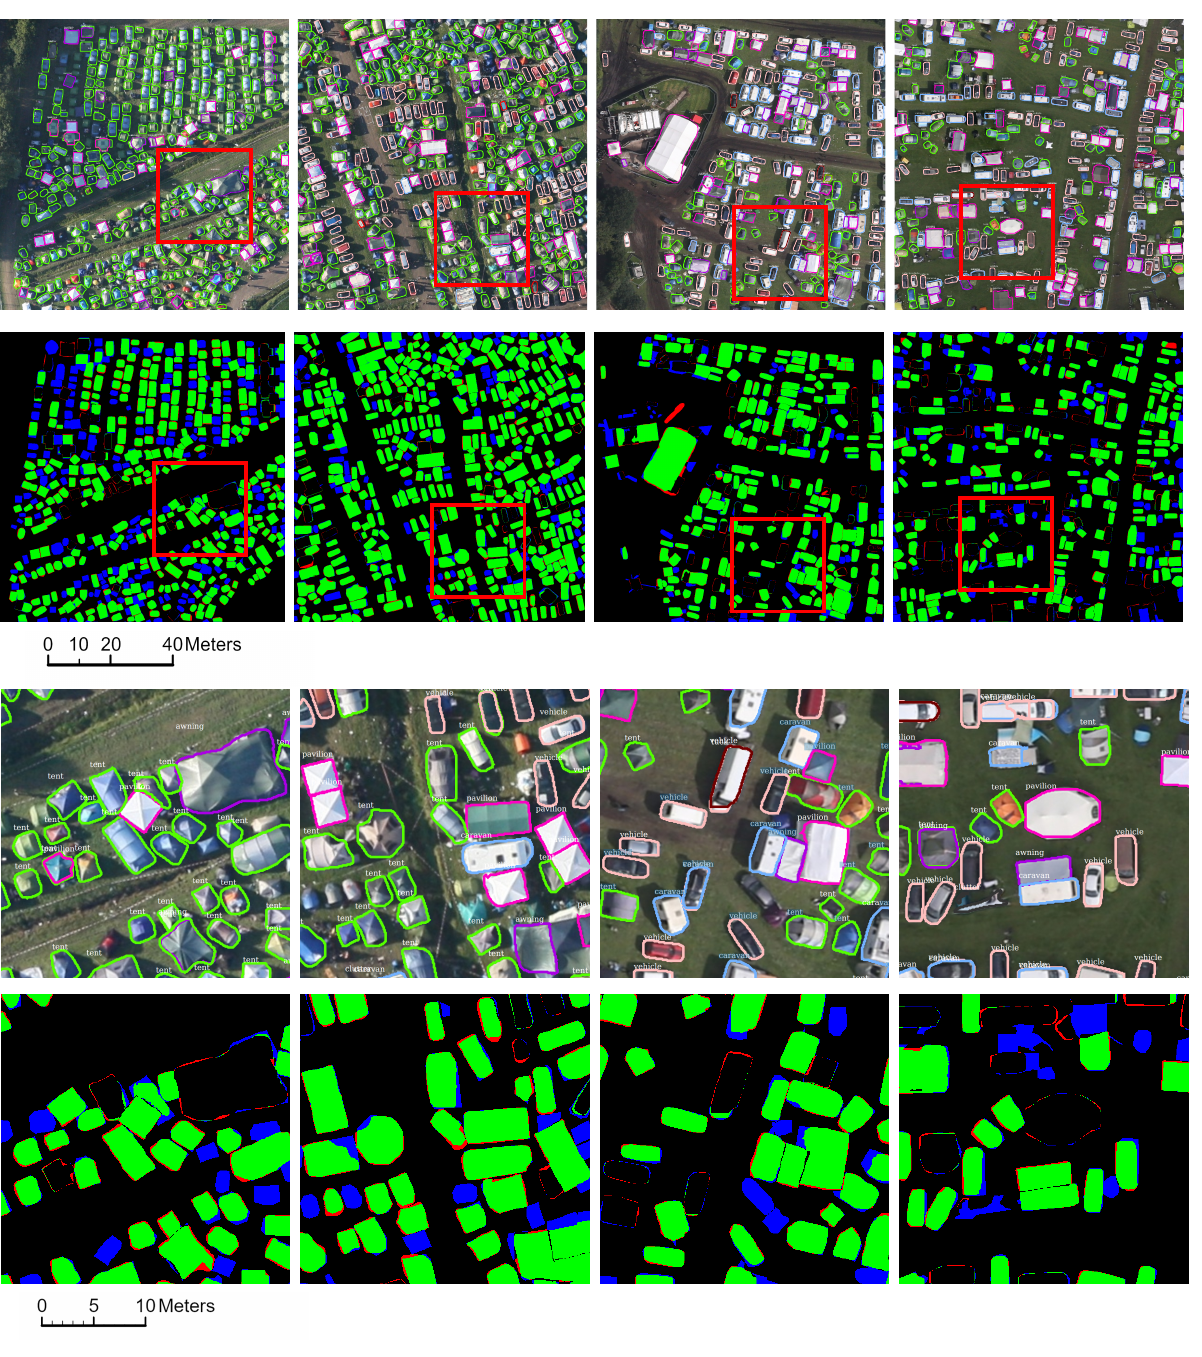
Figure 5. Samples of visual outputs for mask segmentation and confusion in the DLR-AerialTent test set. Color codes for the first and third row: (cid:4)(cid:4)(cid:4)(cid:4)(cid:4)(cid:4)(cid:4)(cid:4)(cid:4)(cid:4)(cid:4)(cid:4)(cid:4)(cid:4)(cid:4)(cid:4)(cid:4) tent: sleep function, (cid:4)(cid:4)(cid:4)(cid:4)(cid:4)(cid:4)(cid:4)(cid:4)(cid:4)(cid:4)(cid:4)(cid:4)(cid:4)(cid:4)(cid:4)(cid:4)(cid:4) small vehicle/transporter, (cid:4)(cid:4)(cid:4)(cid:4)(cid:4)(cid:4)(cid:4)(cid:4)(cid:4)(cid:4)(cid:4)(cid:4)(cid:4)(cid:4)(cid:4)(cid:4)(cid:4) trailer, (cid:4)(cid:4)(cid:4)(cid:4)(cid:4)(cid:4)(cid:4)(cid:4)(cid:4)(cid:4)(cid:4)(cid:4)(cid:4)(cid:4)(cid:4)(cid:4)(cid:4) truck/bus, (cid:4)(cid:4)(cid:4)(cid:4)(cid:4)(cid:4)(cid:4)(cid:4)(cid:4)(cid:4)(cid:4)(cid:4)(cid:4)(cid:4)(cid:4)(cid:4)(cid:4) camper/caravan, (cid:4)(cid:4)(cid:4)(cid:4)(cid:4)(cid:4)(cid:4)(cid:4)(cid:4)(cid:4)(cid:4)(cid:4)(cid:4)(cid:4)(cid:4)(cid:4)(cid:4) pavilion/large tent: assembly and supply function, (cid:4)(cid:4)(cid:4)(cid:4)(cid:4)(cid:4)(cid:4)(cid:4)(cid:4)(cid:4)(cid:4)(cid:4)(cid:4)(cid:4)(cid:4)(cid:4)(cid:4) awning, tarpaulin, (cid:4)(cid:4)(cid:4)(cid:4)(cid:4)(cid:4)(cid:4)(cid:4)(cid:4)(cid:4)(cid:4)(cid:4)(cid:4)(cid:4)(cid:4)(cid:4)(cid:4) inflatable pool, (cid:4)(cid:4)(cid:4)(cid:4)(cid:4)(cid:4)(cid:4)(cid:4)(cid:4)(cid:4)(cid:4)(cid:4)(cid:4)(cid:4)(cid:4)(cid:4)(cid:4) infrastructure, (cid:4)(cid:4)(cid:4)(cid:4)(cid:4)(cid:4)(cid:4)(cid:4)(cid:4)(cid:4)(cid:4)(cid:4)(cid:4)(cid:4)(cid:4)(cid:4)(cid:4) other objects (“clutter”). Confusion color codes for second and fourth: (cid:4)(cid:4)(cid:4)(cid:4)(cid:4)(cid:4)(cid:4)(cid:4)(cid:4)(cid:4)(cid:4)(cid:4)(cid:4)(cid:4)(cid:4)(cid:4)(cid:4) true positive, (cid:4)(cid:4)(cid:4)(cid:4)(cid:4)(cid:4)(cid:4)(cid:4)(cid:4)(cid:4)(cid:4)(cid:4)(cid:4)(cid:4)(cid:4)(cid:4)(cid:4) false positive (wrong class) and (cid:4)(cid:4)(cid:4)(cid:4)(cid:4)(cid:4)(cid:4)(cid:4)(cid:4)(cid:4)(cid:4)(cid:4)(cid:4)(cid:4)(cid:4)(cid:4)(cid:4) false negative (object not